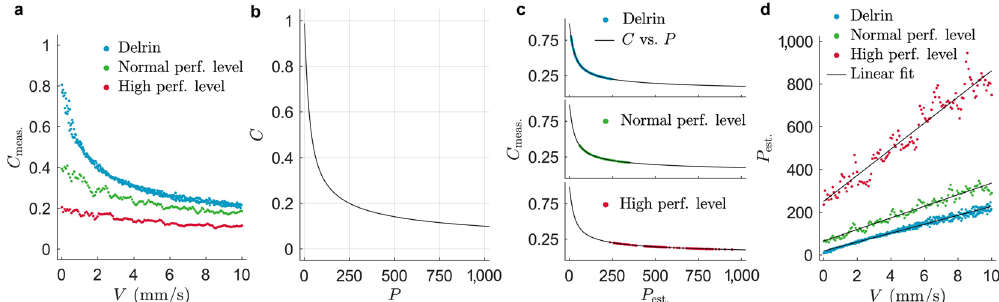
Figure 5. Model examination with motorized displacements of the LSCI system for phantom and in-vivo subjects. ( a ) Measured speckle contrast versus the applied speed. perf.: perfusion. ( b ) Contrast-perfusion lookup table. ( c ) Linear interpolation of the estimated perfusion data points from the measured speckle contrast according to the contrast-perfusion lookup table. vs.: versus. ( d ) Estimated perfusion as a function of the applied speed overlapped with a linear fit for each